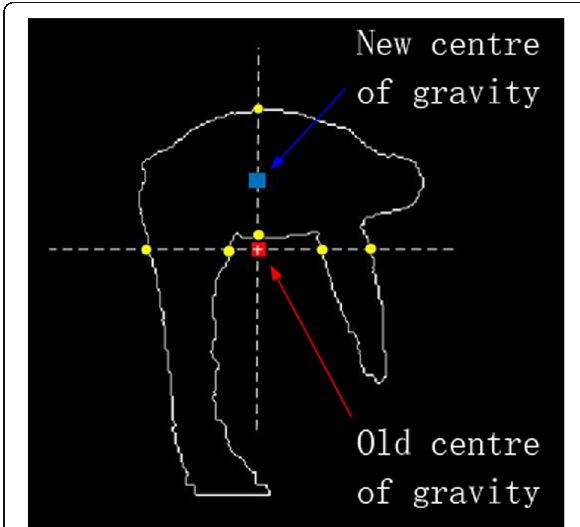
Fig. 4 Replacing the center of gravity of the human